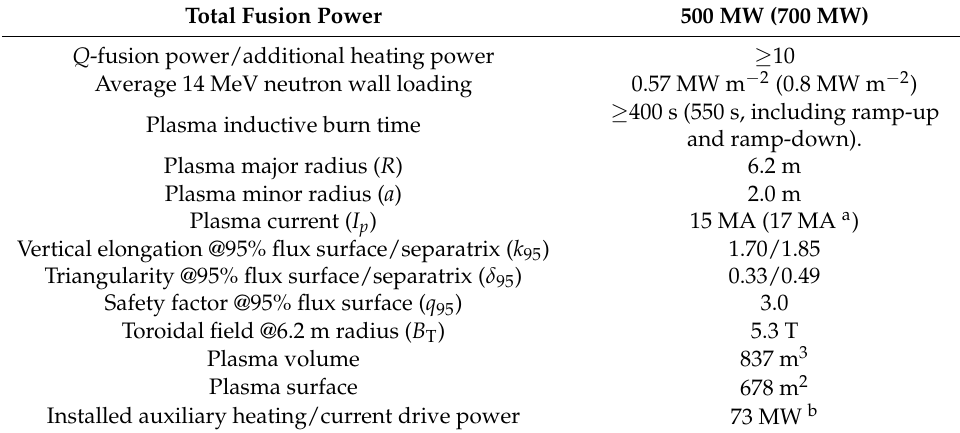
Table 3. ITER Tokamak operating parameters (from ITER Technical Basis